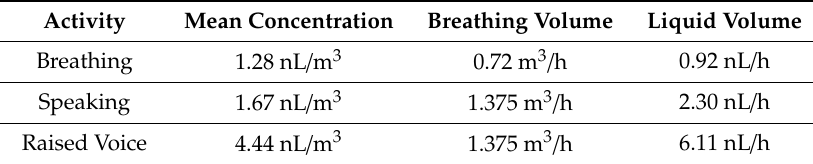
Table 4. Amount of liquid released over one hour, by